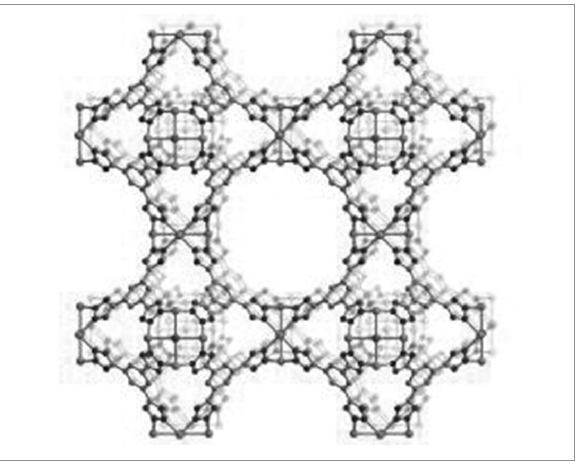
Figure 8: Structure of a typical metal organic framework. 29